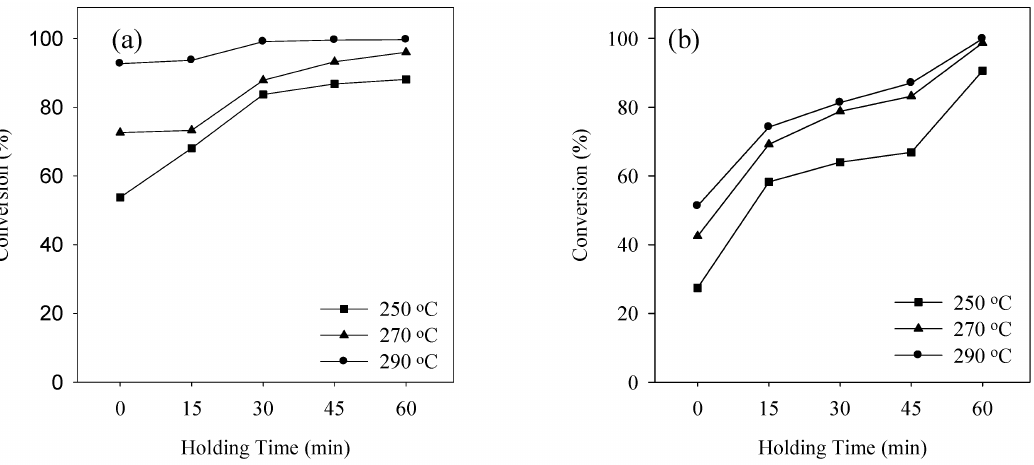
Figure 4. Conversion at various reaction temperature using ( a ) SCM and ( b ) SCE for waste pig fat to alcohol ratio of 1:2.5.